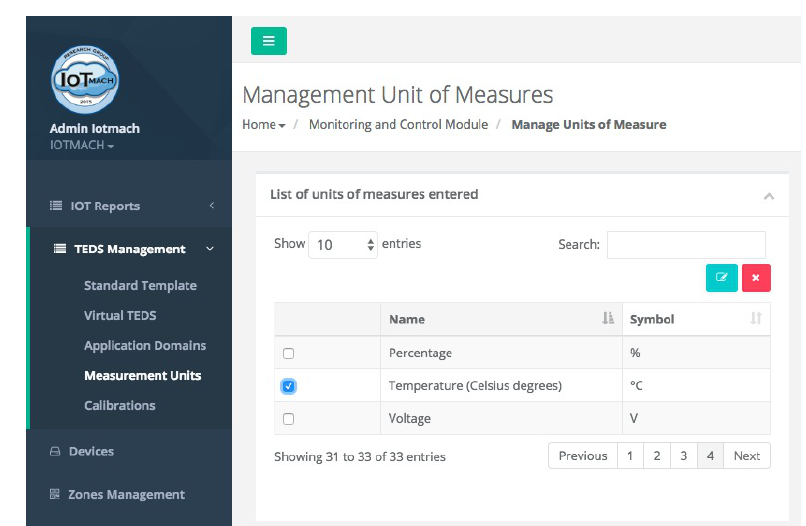
Figure 18. Application domain menu.